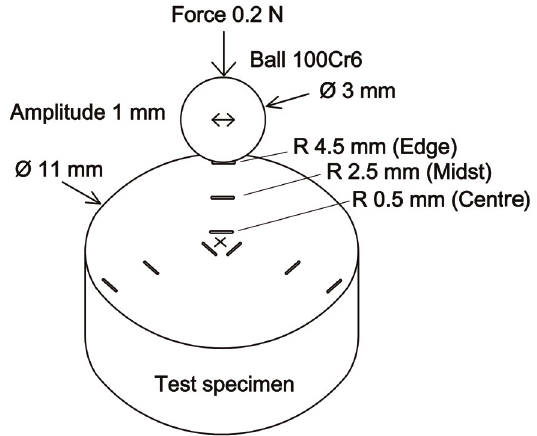
Fig. 2. Demonstration of the tribosystem and the location of the wear tracks on the surface of the specimen.